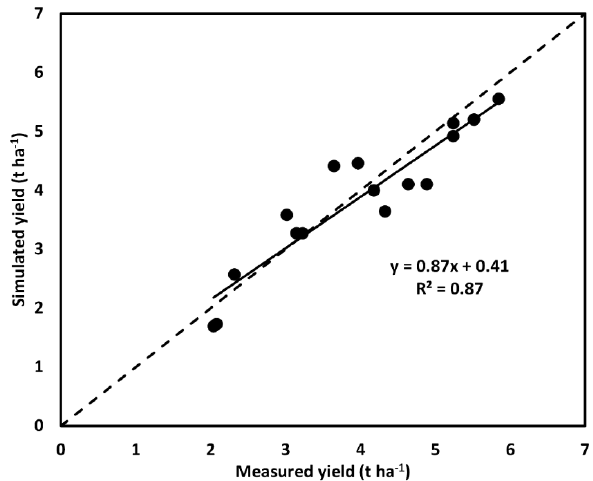
Figure 7. Measured and simulated yield of faba bean in 2017 and 2018 under different watering regimes, sowing dates, and sowing rates.